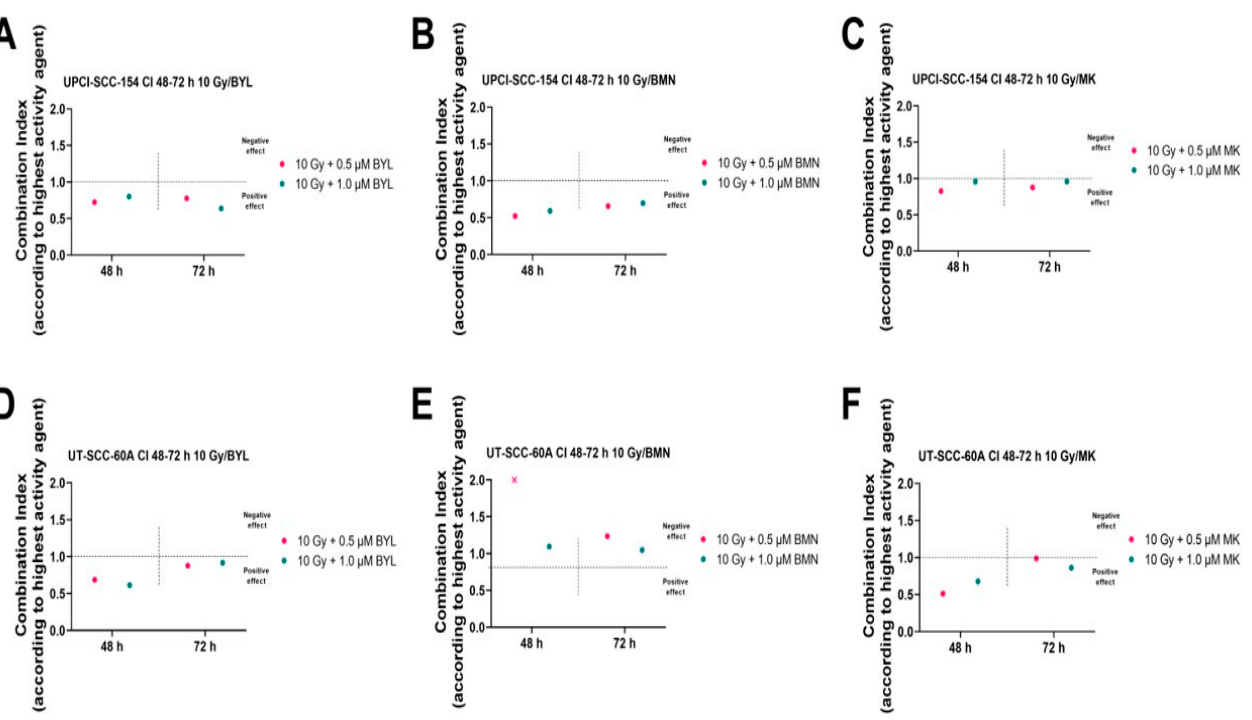
Figure 2. Combinational effects on HPV + UPCI-SCC-154 and HPV − UT-SCC-60A upon adding 10 Gy to PI3K inhibitor BYL719 ( A , D ), to PARP inhibitor BMN-673 ( B , E ), and to WEE-1 inhibitor MK-1775 ( C , F ). Combination indices (CIs) were shown with the highest single agent approach after 48 and 72 h, where CI < 1 shows a positive and CI > 1 a negative combination effect. CIs were calculated from the mean of three experiments analyzed by WST-1 assays at 48 and 72 h after treatment. BYL denotes BYL719, BMN denotes BMN-673, and MK denotes